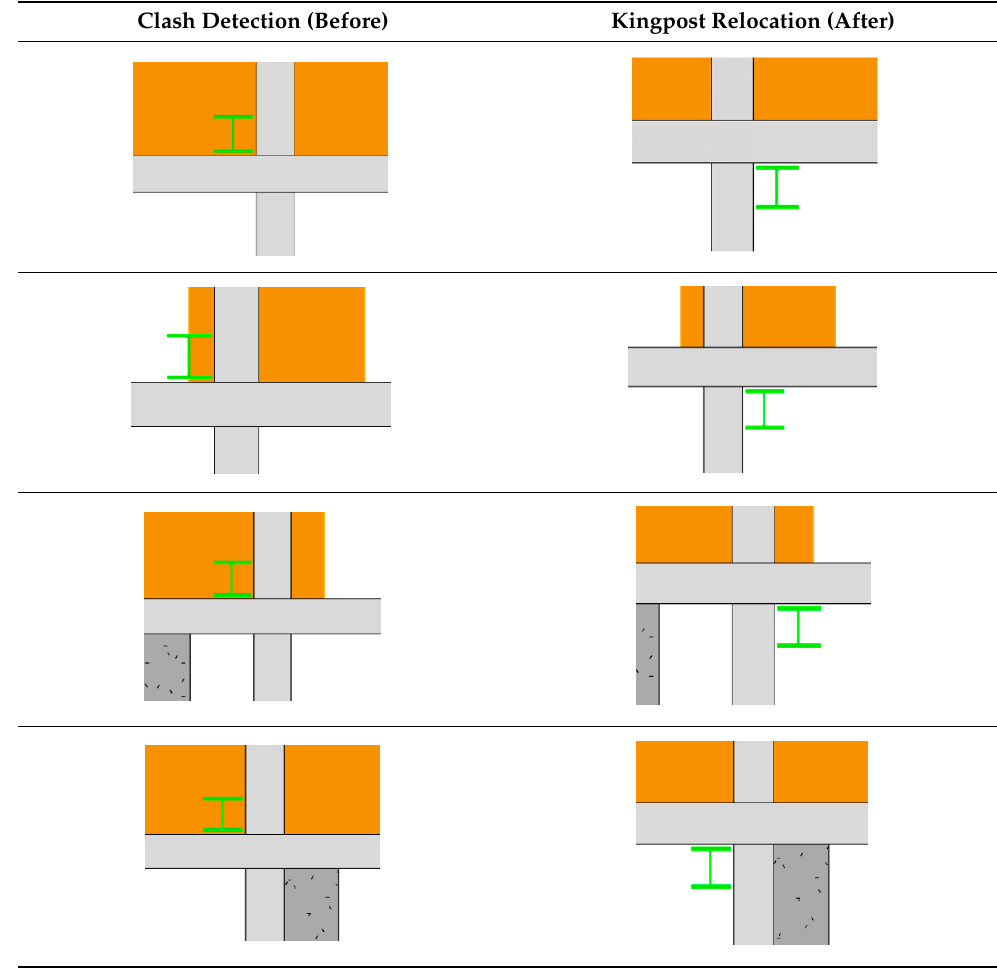
Table 10. Results of the kingpost relocation. Clash Detection (before)